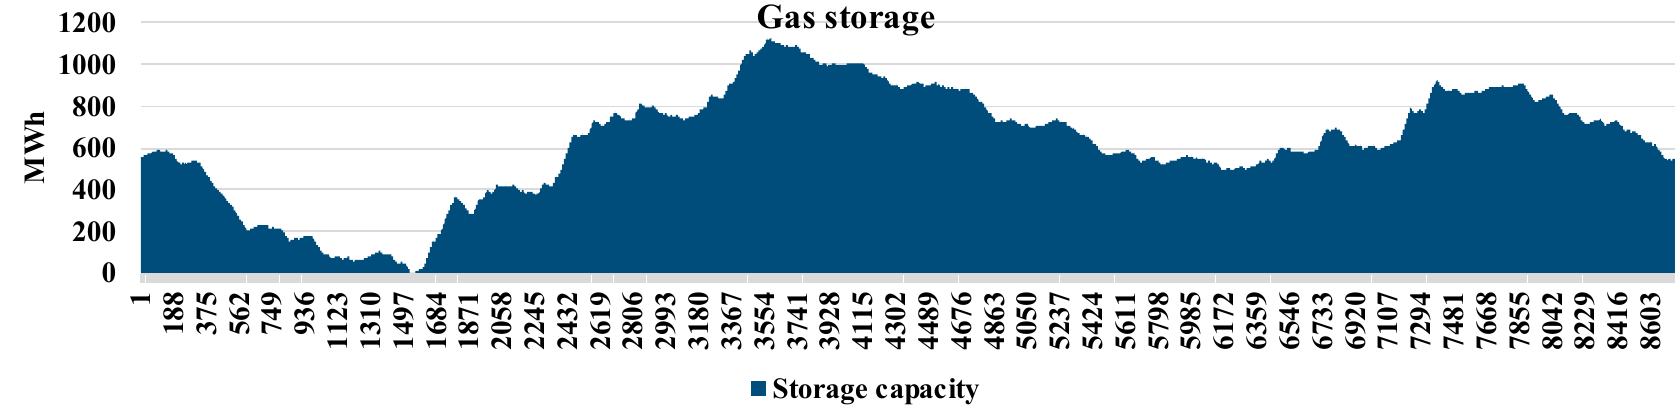
Figure 6. Hourly grid gas storage levels (MWh gas ) for the year. Maximum storage capacity is 1200 MWh gas . High levels of gas storage appear to be associated with higher generation of wind power. Gas storage becomes lower during the summer months when solar PV generation is at its maximum.